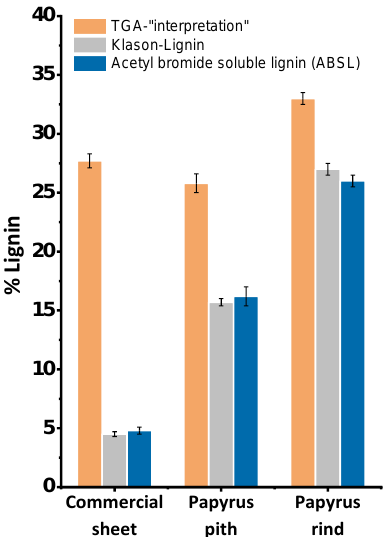
Figure 3. Lignin contents of a commercial papyrus sheet, native pith, and native rind, determined by TGA as compared to Klason-Lignin and acetyl bromide soluble lignin (ABSL).